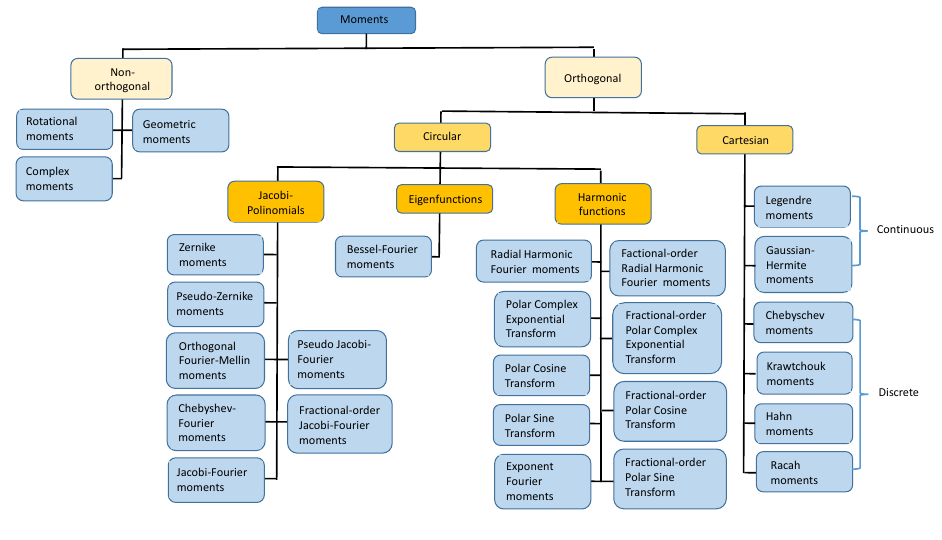
Figure 1. A schematic classification of image